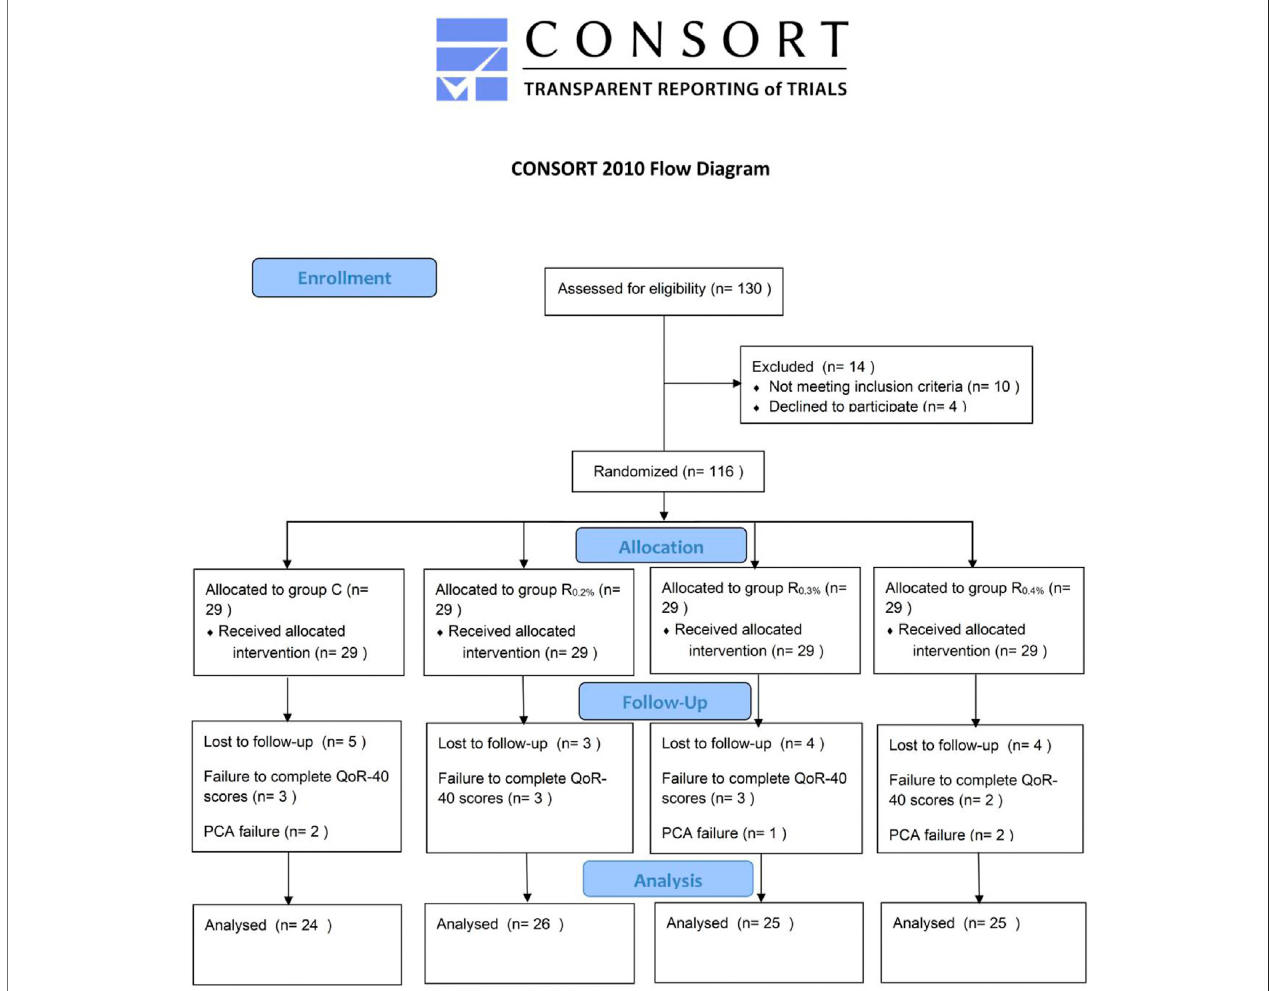
FIGURE 1 | Consolidated standards of reporting trials statement fl ow diagram for the study.